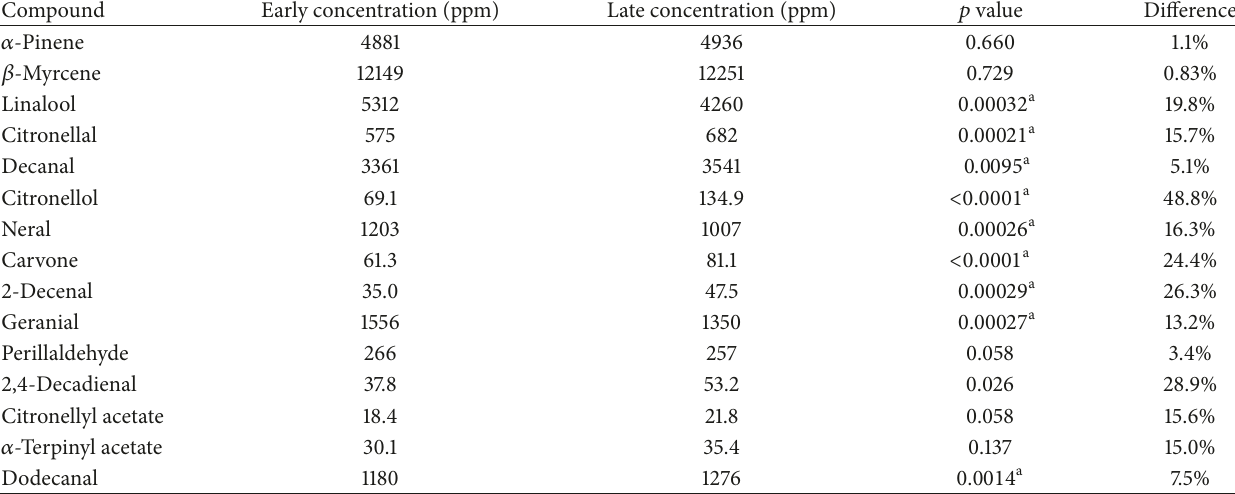
Table 9: Valencia asymptomatic early versus late compound concentration.